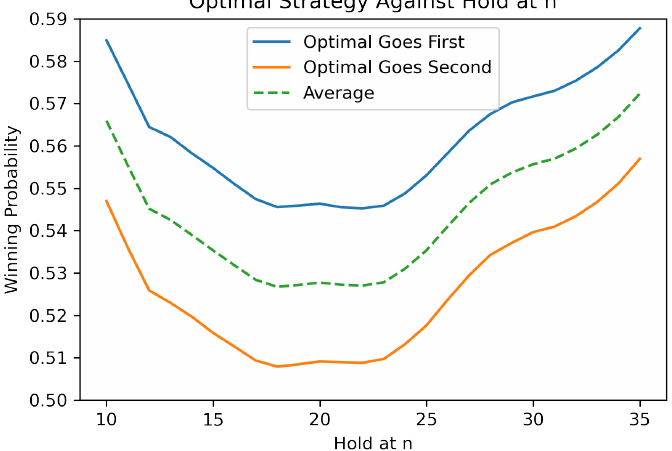
Figure 8. Winning probabilities of the optimal strategy developed in this work against the traditional “hold at n” strategy for “Double Trouble”, a variation of the standard two-dice Pig